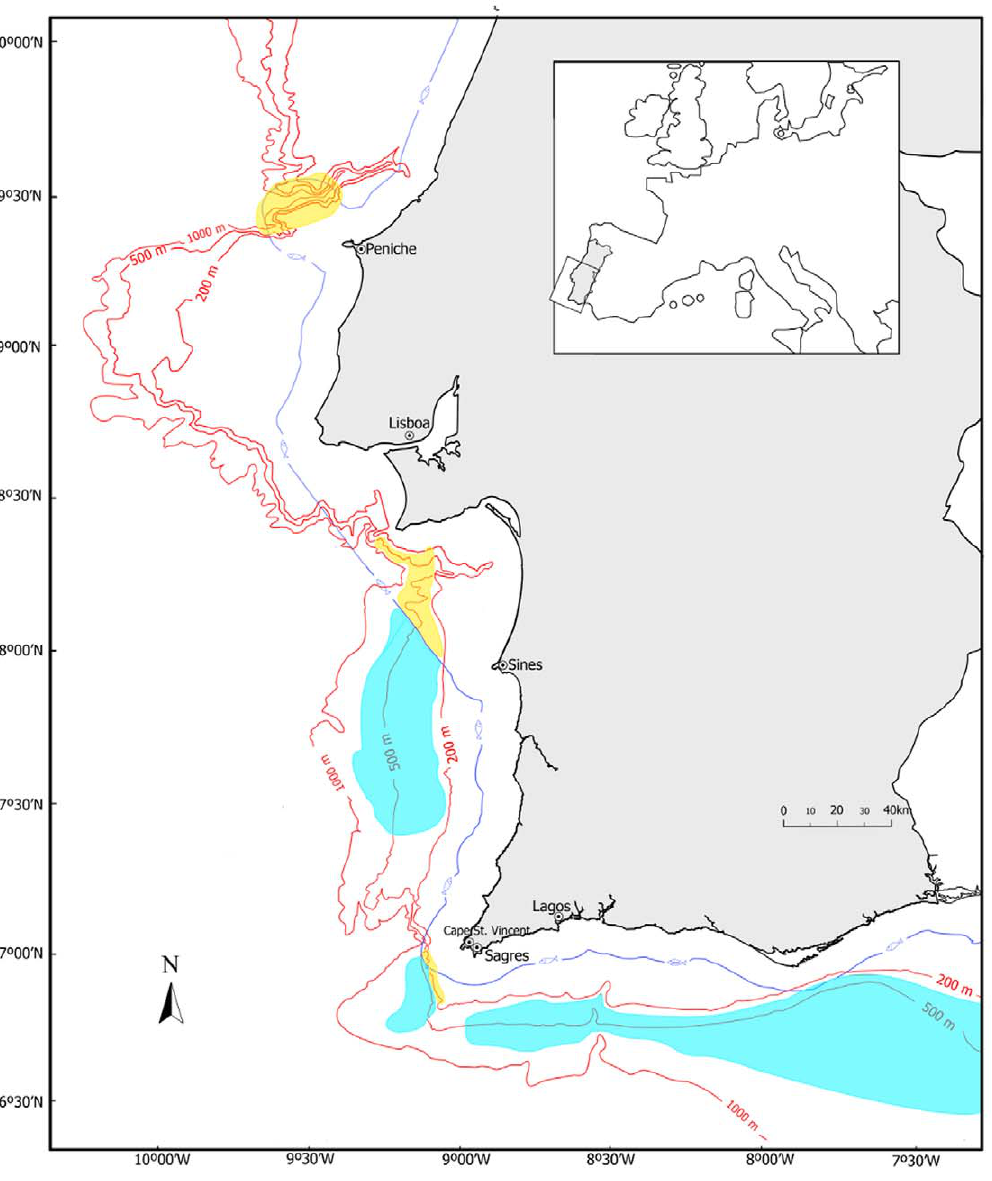
Figure 2. Map showing the location of the fishing grounds. Traditional fishing grounds are shown: fishing grounds explored with trawling in blue and creeling in yellow. Sampling for this work was done NE of Peniche (creels) and off Lagos on the south coast (trawl). Sources of information for mapping the fishing grounds: [32–34].